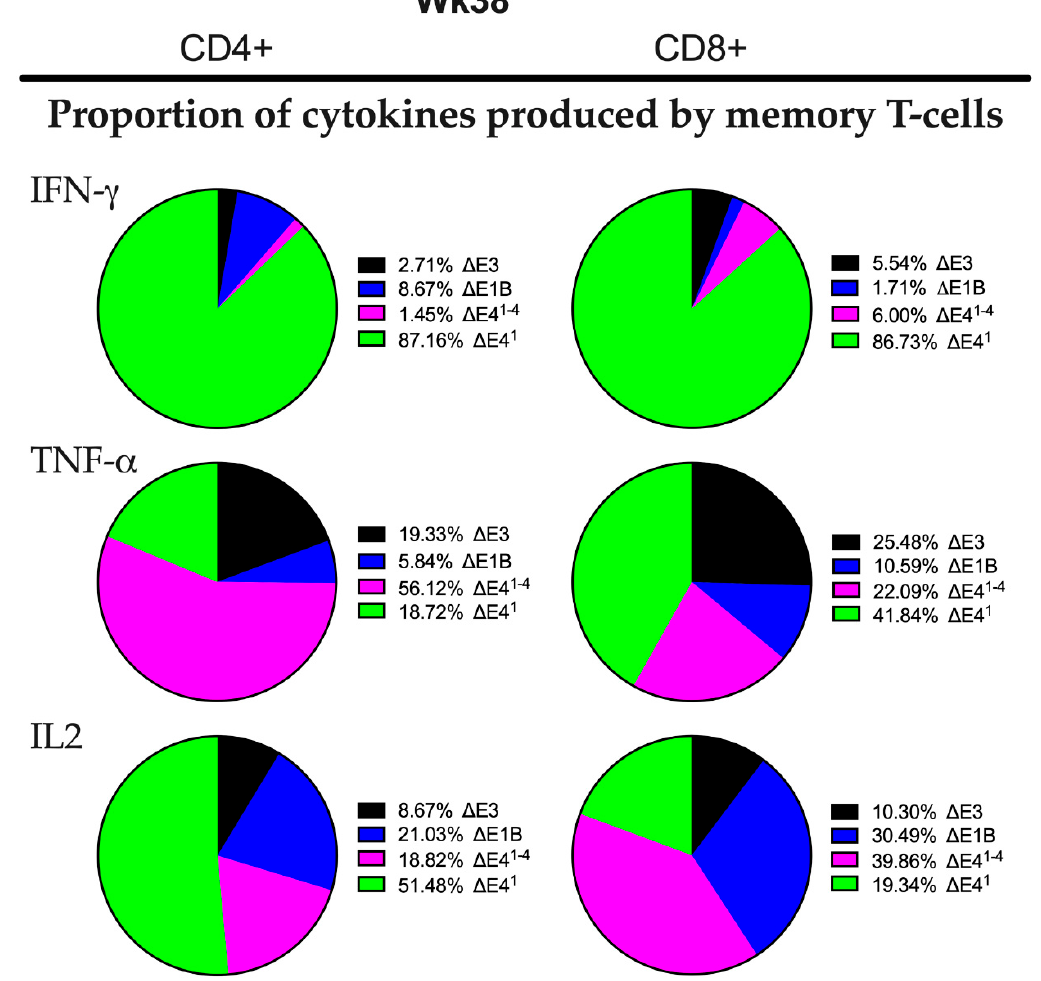
Figure 4. Pie chart comparison of the relative numbers of cytokine-producing memory T-cells for each Ad vector. The total numbers of cytokine-producing memory T-cells for each vector at wk 38 post-immunization were graphed as a proportion of the total number of cytokine-producing memory T-cells for each cytokine.